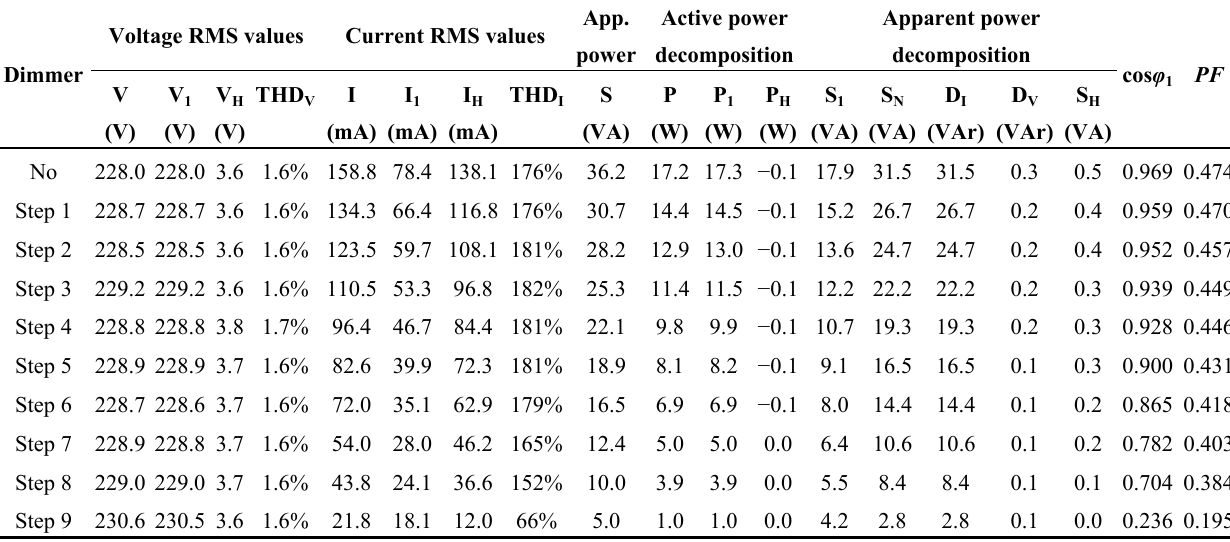
Table 1. Power quality analysis of the measurements results for 21 W LED panel with 36 W ballast.